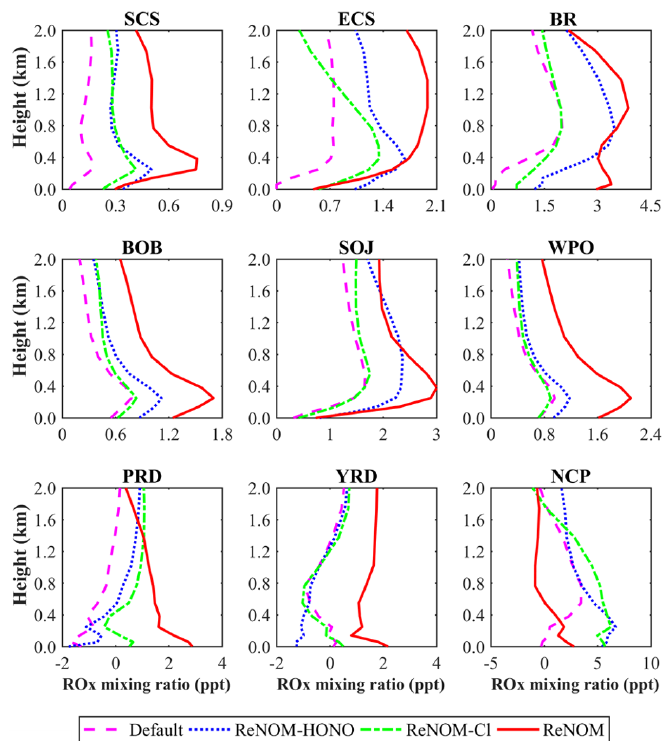
Figure 5. Vertical profiles of daytime RO x changes due to ship emissions (in pptv) from different chemistry in the nine regions.